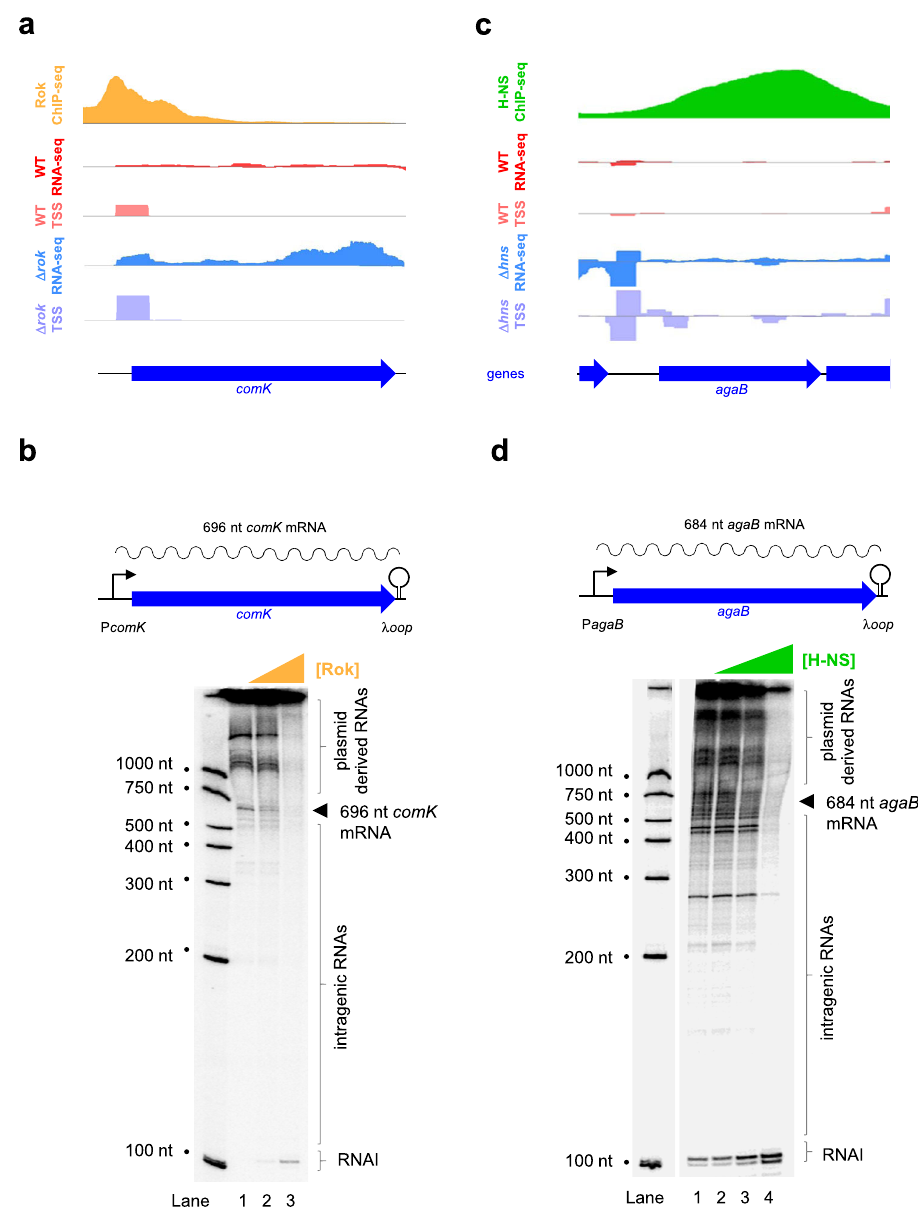
Fig. 2 Housekeeping RNA polymerases of E. coli and B. subtilis differ in their promiscuity. a Rok represses transcription of the B. subtilis comK mRNA in vivo. Data for Rok occupancy (orange) 35 , total RNA abundance (red and blue) and transcription start site (TSS) usage (pink and mauve) are shown. Sequence reads mapping to the top and bottom DNA strands are shown above and below the central horizontal line in each plot. The y -axis scales are identical for data obtained using wild-type and Δ rok cells for each type of experiment. Genes are shown by blue arrows. b Rok represses transcription of the B. subtilis comK mRNA in vivo. The schematic illustrates the comK gene and regulatory region, cloned in plasmid pSR, and used as a template for in vitro transcription. The comK TSS is shown as a bent black arrow, the comK gene is shown as a block blue arrow, and the sequence encoding the λ oop transcriptional terminator is indicated by a stem loop schematic. B. subtilis σ A RNA polymerase (0.5 μ M) and Rok (0, 0.5, or 1.0 μ M) were added as indicated. Note that the 696 nt comK mRNA is easily discernible and there is no evidence for transcription initiation within comK . Species of RNA over ~1000 nt in length are derived from sites elsewhere on the plasmid template. The RNAI transcript is encoded by the plasmid replication origin. The experiment was done twice with similar results. c H-NS represses transcription initiation within the E. coli agaB coding sequence in vivo. Data for H-NS occupancy are in green 32 and otherwise as indicated in ( a ) except that wild-type and Δ hns E. coli cells are compared. d H-NS represses transcription initiation within the E. coli agaB coding sequence in vitro. The schematic illustrates a section of DNA cloned in plasmid pSR and used as a template for in vitro transcription. The expected size of the agaB mRNA is 684 nucleotides (nt). The gel image shows transcripts generated by E. coli σ 70 RNA polymerase (0.5 μ M) using this DNA template. The expected position of agaB mRNA is indicated by an arrow head but is obscured by many similarly sized and smaller transcripts derived from agaB coding sequence. H-NS was added at concentrations of 0, 0.5, 1.0 or 2.0 μ M. The experiment was done twice with similar results.